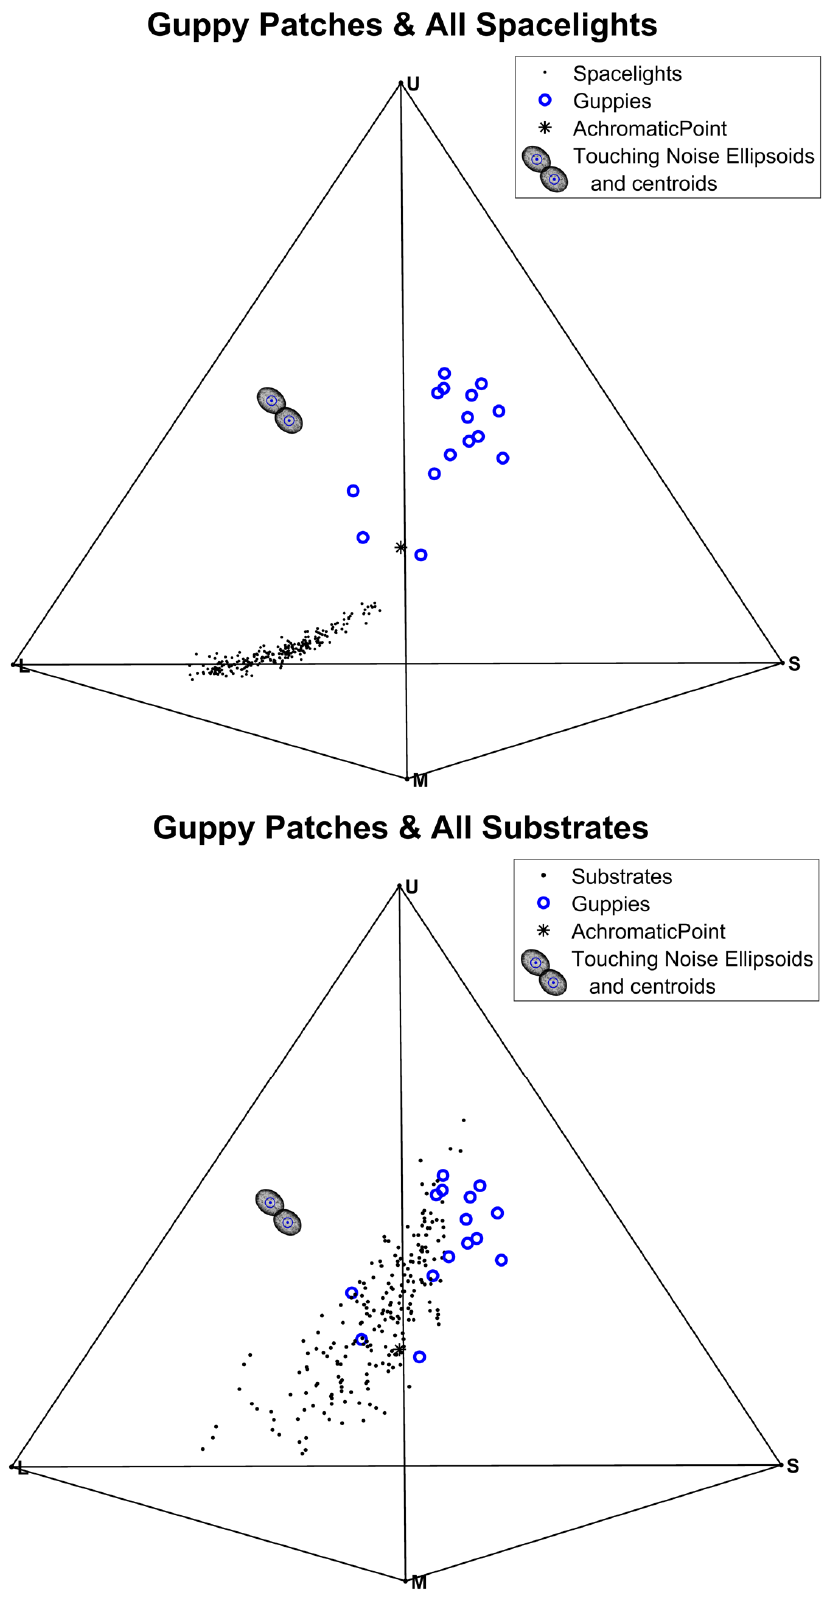
Figure 3. Chromatic (color) cone capture diagrams for guppy spots, spacelight and substrates in tetrahedral color space. Any point in the tetrahedron represents the relative values of four cone captures, which are the distances between a point and each tetrahedron face. Receptor noise